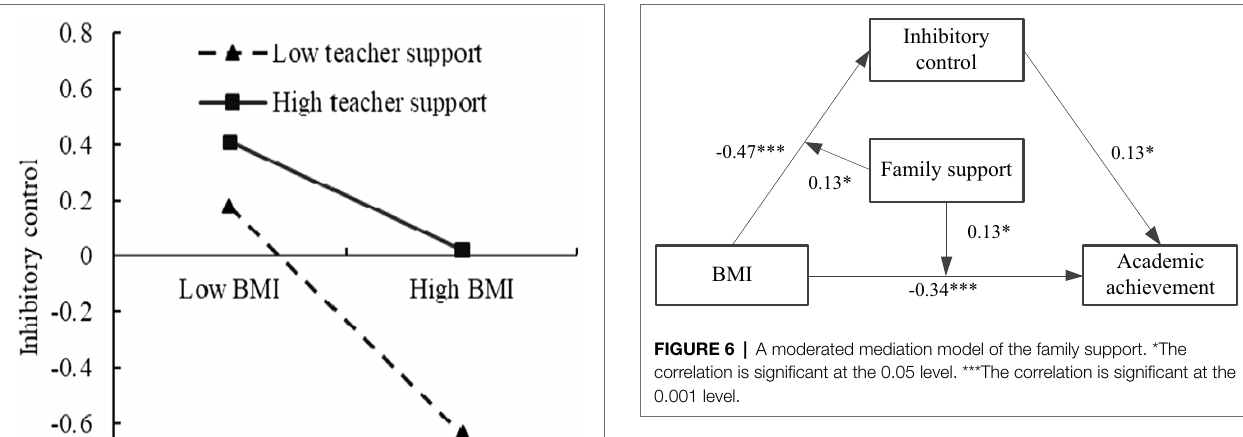
t = − 6.56, p < 0.001), and the effect of BMI × peer support to inhibitory control was not significant ( β = 0.02, t = 0.49,